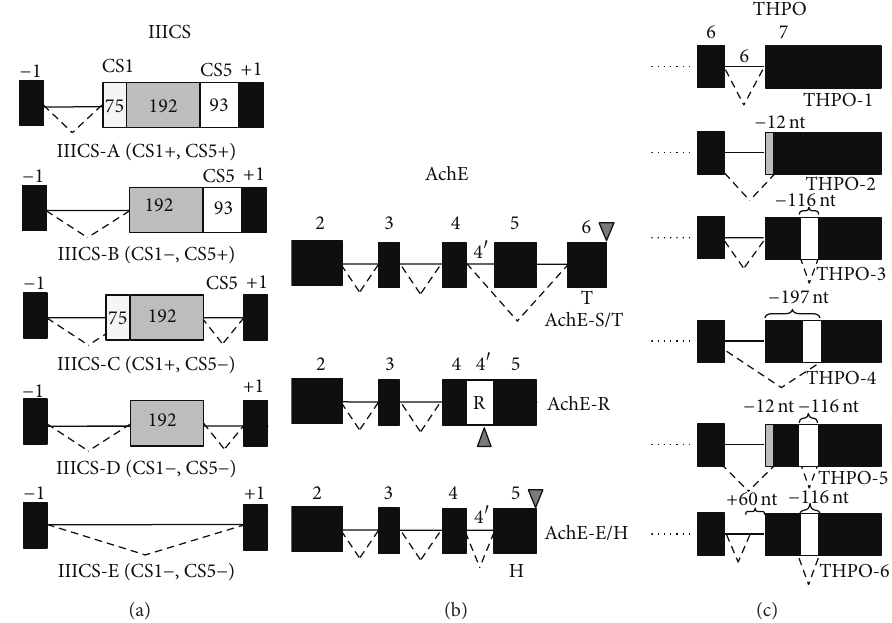
Figure 2: Pseudointrons whose alternative splicing can be altered in tumors. Schemes of pseudointron alternative splicing events shown to occur within the Fibronectin (IIICS, (a)), Acetylcholinesterase (AchE, (b)), and Thrombopoietin (THPO, (c)) genes. Pseudointrons are shown as white boxes in IIICS (CS5-93nt), AchE (4 󸀠 -R), and THPO (116nt). Solid lines indicate introns and dotted lines distinguish the different splicing events. The C-terminal sequence of each splicing variant for each gene is also shown. For IIICS and THPO, additional exonic elements undergoing alternative splicing are shown as gray boxes. In the AchE gene, gray triangles indicate stop codon within different ORFs. See text for definition of each splice